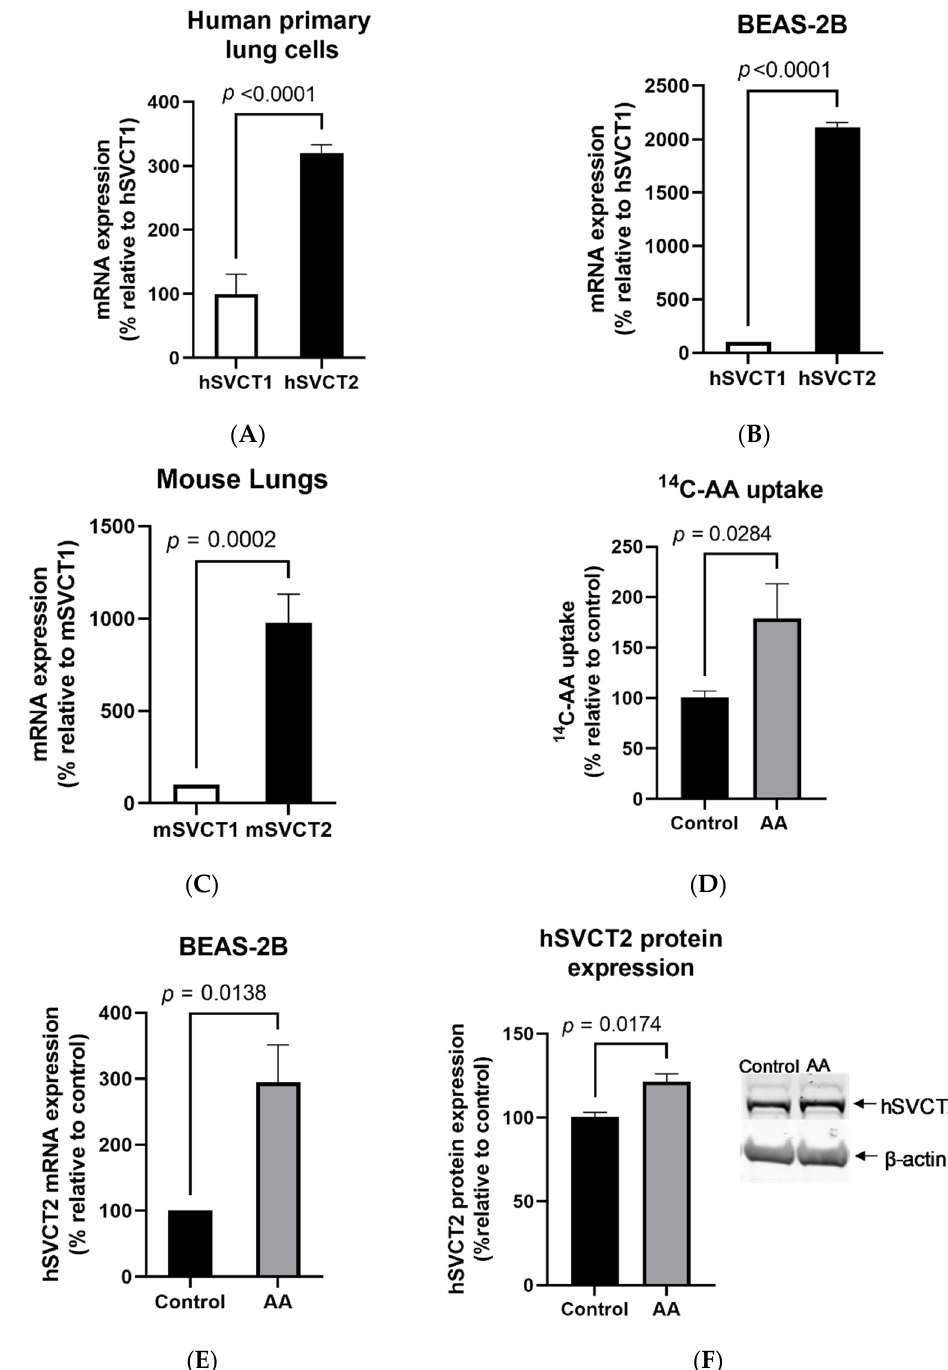
Figure 1. Vitamin C transporter expression and function in the lungs. The expression of the vitamin C transporters SVCT1 and SVCT2 was determined using RT-qPCR in ( A ) human primary bronchial epithelial cells; ( B ) BEAS-2B cells; and ( C ) native wild-type mouse lungs. ( D ) To determine the effect of vitamin C/ascorbic acid (AA) treatment on 14 C-AA uptake and SVCT2 expression levels, the BEAS-2B cells were exposed to vitamin C (100 μ M, 24 h) and carrier-mediated 14 C-AA uptake was performed. Expression of ( E ) SVCT2 mRNA and ( F ) protein levels were determined for isolated mRNA and proteins by RT-qPCR and Western blot analysis, respectively. Data are means ± SE of at least 3–4 independent sample preparations.